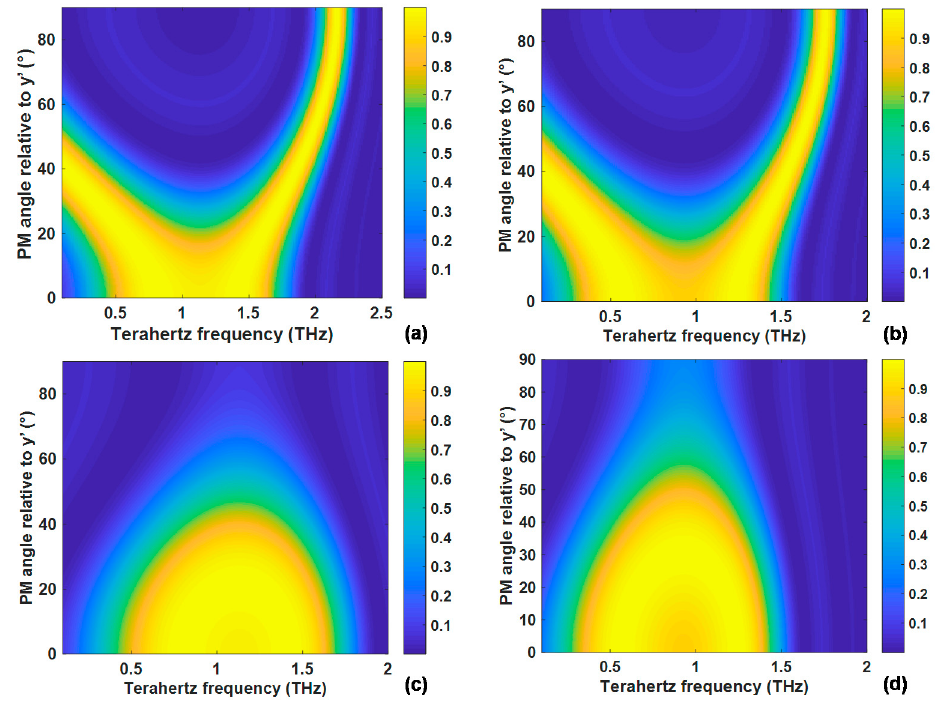
Figure 4. Relative PM efficiency of collinear angle tuning in ZnTe and CdTe with a 9 kV voltage along the [001] direction: ( a , b ) are the tuning characteristics in the x’oy’ plane and ( c , d ) are the tuning characteristics in the y’oz’ plane for ZnTe and CdTe, respectively.